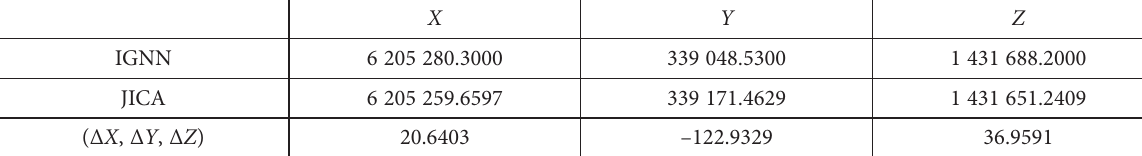
Table 7. Parameters of translation at point no. 65